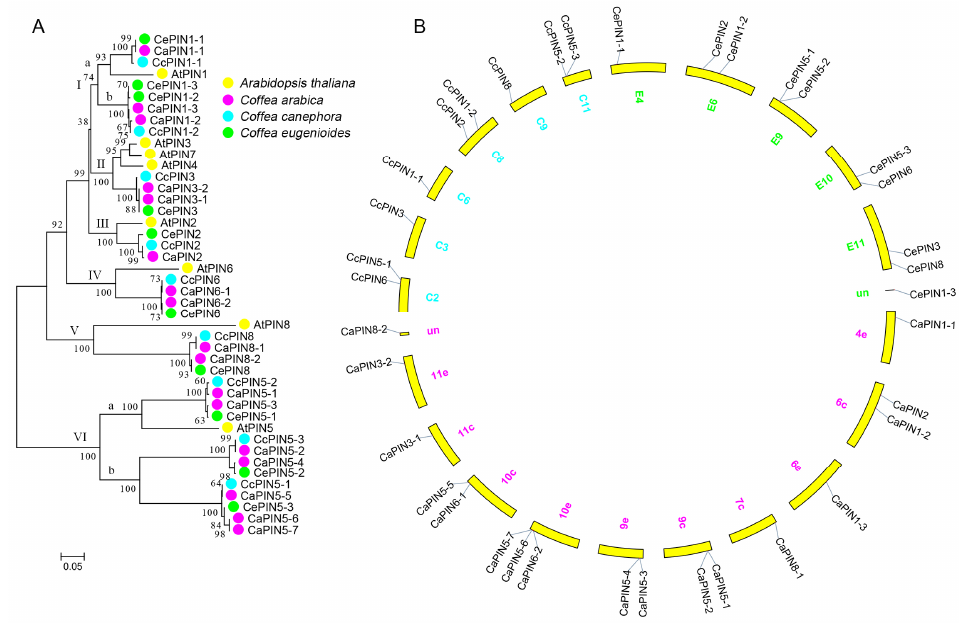
Figure 1. Phylogenetic ( A ) and chromosomal distribution ( B ) of the coffee PIN family. The protein sequences of Arabidopsis thaliana , C. arabica , C. canephora and C. eugenioides are shown in yellow, pink, blue and green, respectively (A). The chromosome numbers are listed beside chromosomes (yellow) for C. arabica (pink), C. canephora (blue) and C. eugenioides (green). The un represents the unanchored scaffold.